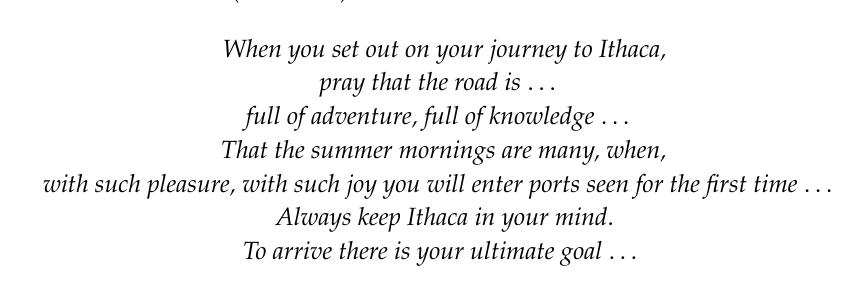
Figure 12. The journey to Ithaca. (Adapted from: http://santoriniconference.org/ ). Ithaca– Konstantinos Kavafis (1863–1933).